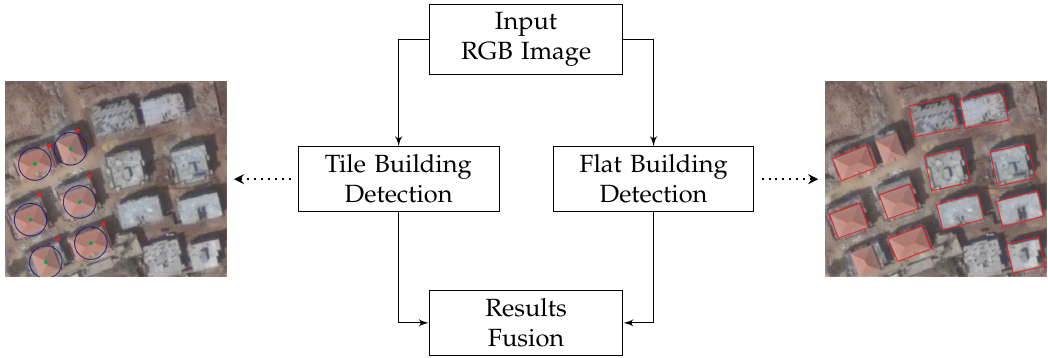
Figure 1. A Building Detection with Shadow Verification (BDSV) block